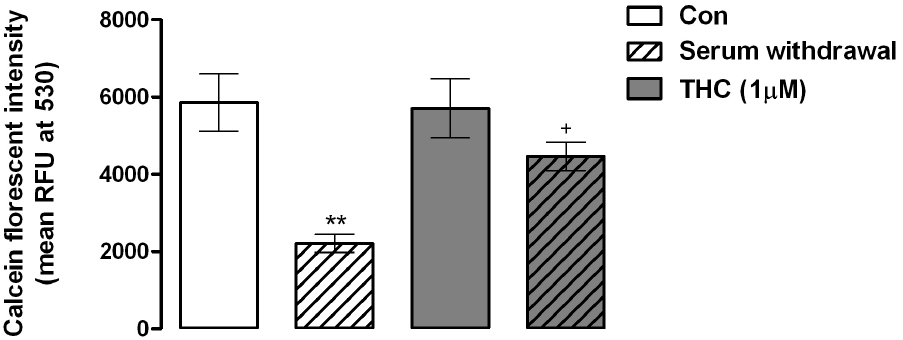
Figure 1. The phytocannabinoid, ∆ 9 -THC enhances the survival of MSCs during cellular stress. Serum withdrawal significantly reduced the metabolic function of MSCs compared to control MSCs (Con; ** p < 0.01, 1-way ANOVA and Newman-Keuls, n = 4) as assessed by the ability of MSCs to metabolize the fluorescent substrate calcein AM. Treatment of MSCs with ∆ 9 -THC (1 µ M, 24 hours) protected MSCs from serum withdrawal compared to serum deprived MSCs (Serum withdrawal; + p < 0.05, 1-way ANOVA and Newman-Keuls, n =